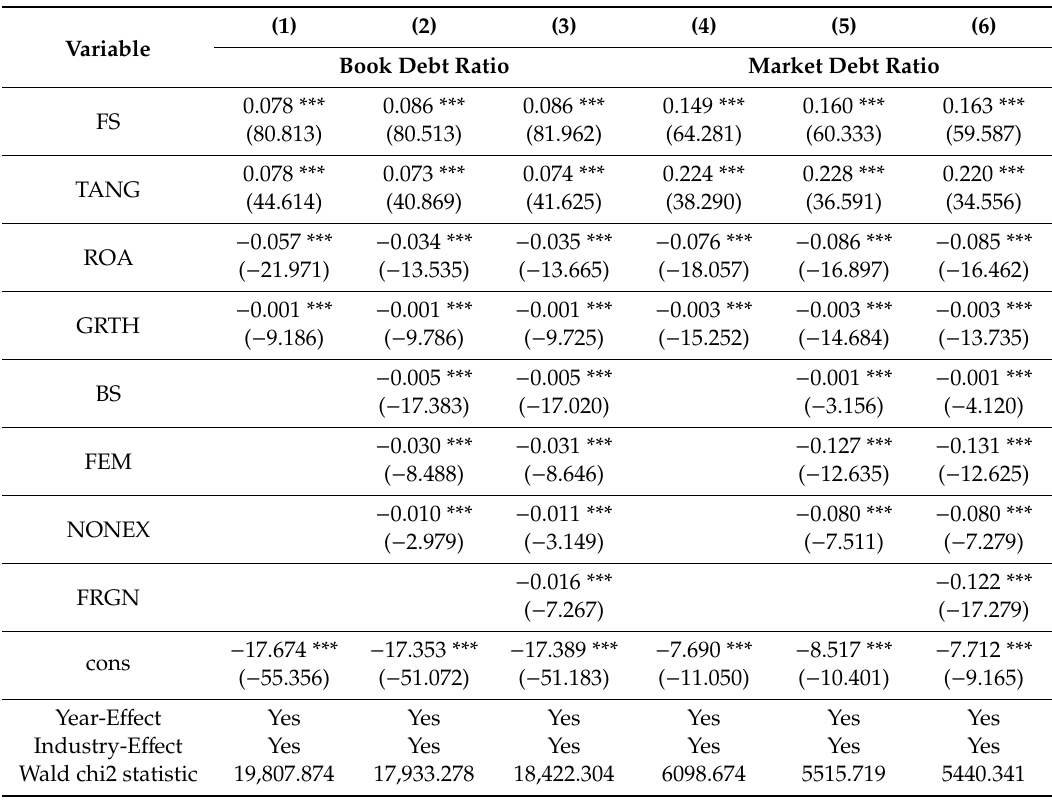
Table 4. Robustness checks (2). Table 4 shows the results of regression analysis for both baseline and extended model using xtgls. The dependent variable for models 1–3 is book debt ratio measured by total debt divided by total assets, and for models 4–6, it is market debt ratio measured by total debt divided by market. Asterisks indicate significance at 1%